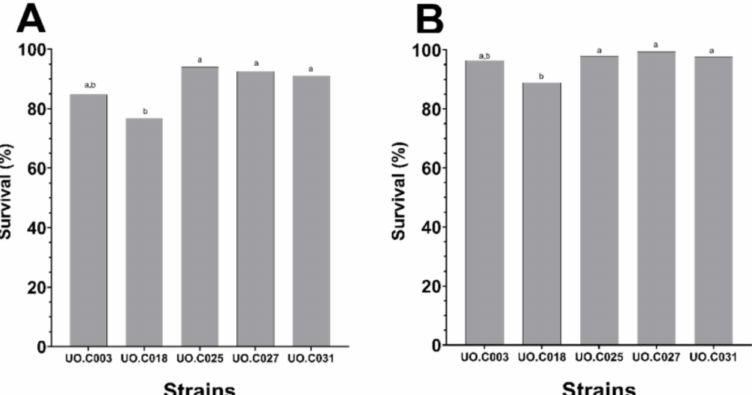
Figure 3. Percentage of survival of selected bioactive strains under acidic pH 2.6 (Gizzard, A ) and pH 4.5 (Crop, B ) in a simulated gastric juice. a and b labels the strains that exhibit significant differences in their survival at each pH.